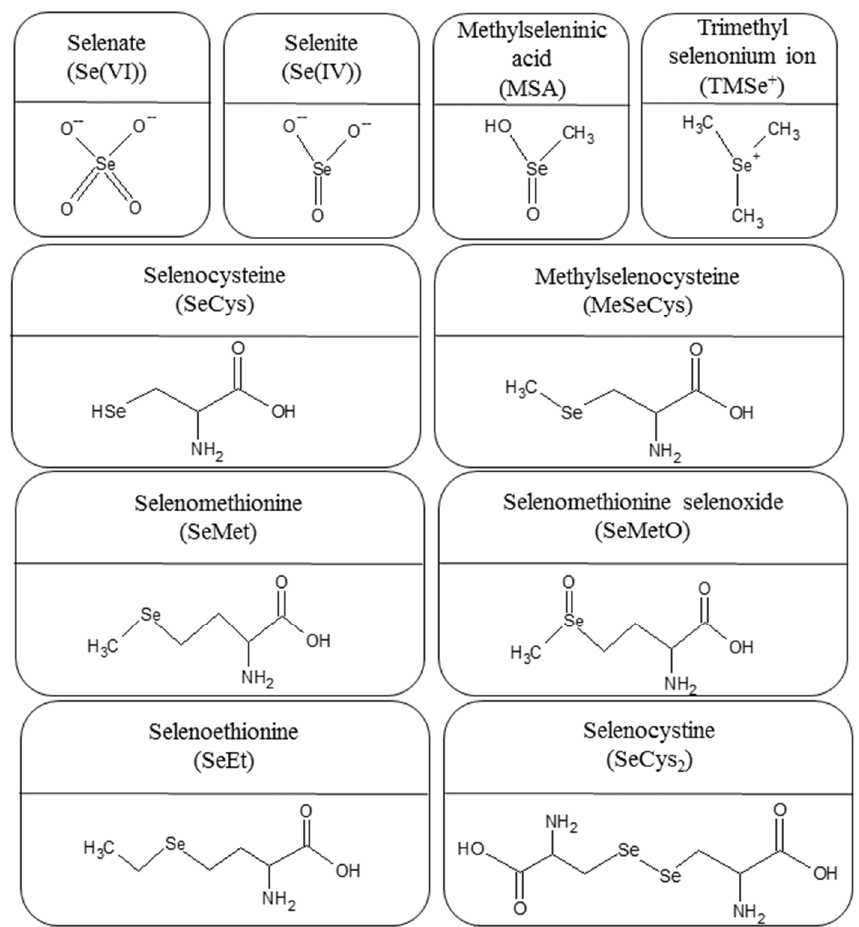
Figure 1. Some selenium species commonly detected in environmental, biological, and food sam-